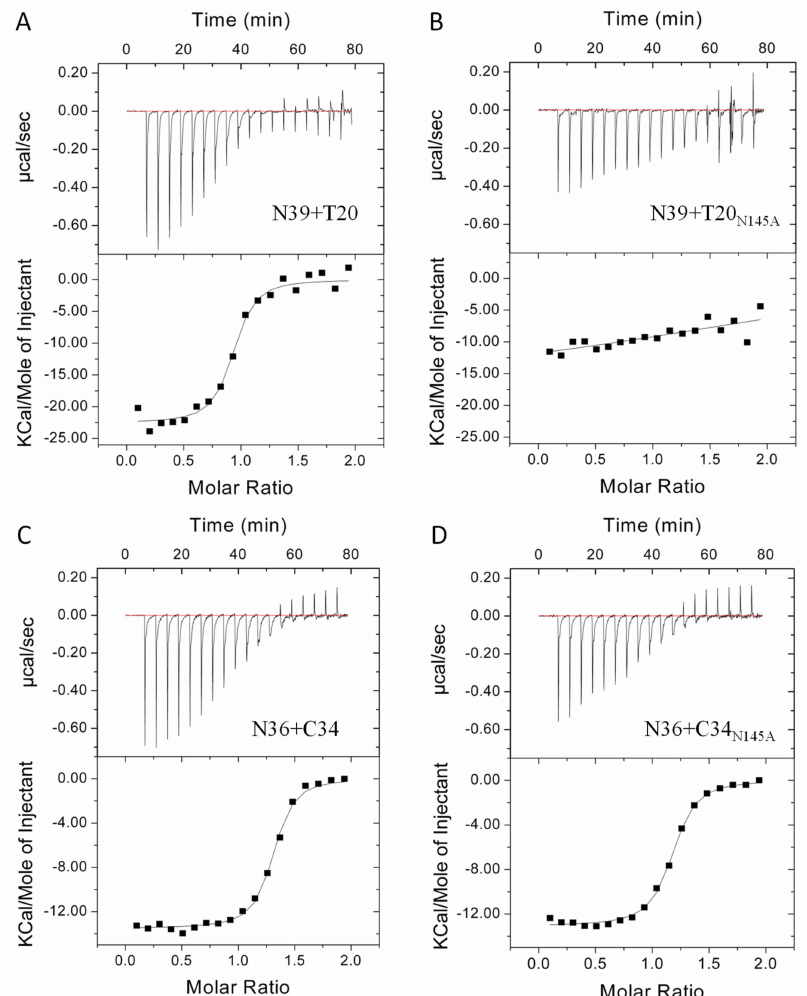
Figure 5. E ff ects of the N145A mutation on the interactions of the N- and C- terminal heptad repeats (NHR and CHR) helices determined by isothermal titration calorimetry (ITC). Thermodynamic profiles of the molecular interactions between N39 and T20 ( A ), N39 and T20 N145A ( B ), N36 and C34 ( C ), and N36 and C34 N145A ( D ) were respectively measured. The titration traces are shown at the top, and the binding a ffi nities are shown at the bottom. The experiments were repeated two times, and representative data are